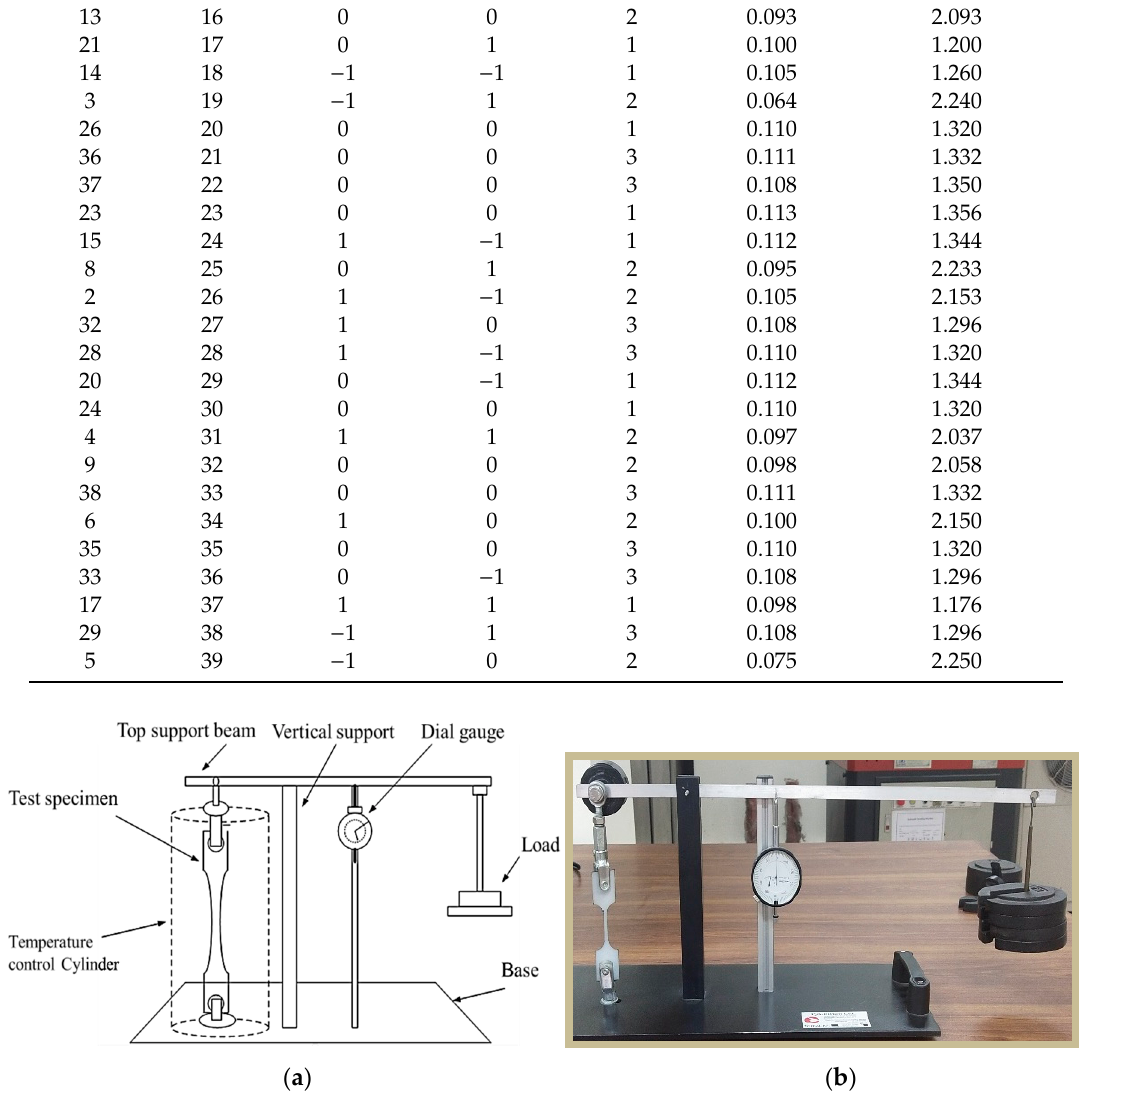
( b ) Figure 4. ( a ) Creep test specimen as per ASTM D2990 standards. ( b ) Printed creep specimens. 3. Results and Discussion 3.1. Model fitting and Analysis of Variance Analysis of variance (ANOVA) is performed to analyze the effect of input process parameters, i.e., layer height, infill percentage, and infill pattern on the responses such as creep rate (1/s) and rupture time (h) of PLA. To ensure the adequate prediction of responses compared to the experiments, the evaluation of a fitted model is essential. The prediction models of creep rate and rupture time based on CCD design for each infill pattern are expressed in Equations (1)–(6). Equations (1)–(3) represent the creep rate in terms of coded units, and Equations (4)–(6) represent the rupture time in terms of coded factors. Diamond pattern = 0.109 − 0.001 L − 0.004 I − 0.004 L 2 − 0.001 I 2 − 0.001 L × I,